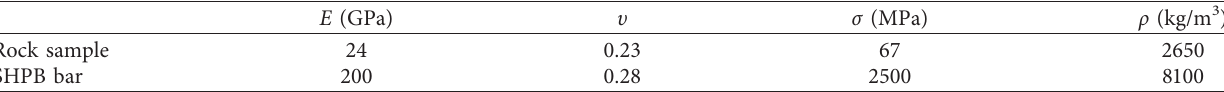
Table 1: The material properties of SHPB